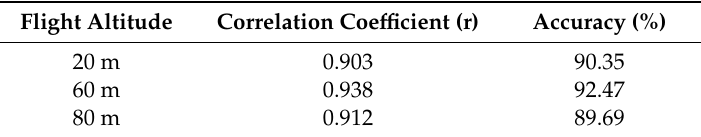
Figure 10. Histogram of difference for CPA diameter between different flight altitudes: ( a ) 60 m and 20 m, ( b ) 80 m and 20 m, and ( c ) 80 m and 60 m. Table 4. Correlation and accuracy value of CPA diameter. Flight Altitude Correlation Coe ffi cient (r)